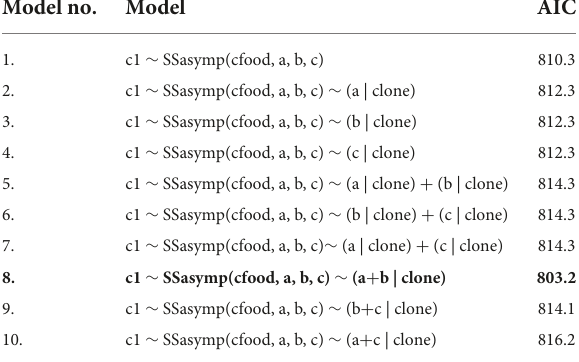
TABLE 5 First clutch abundance reaction norm models, fitted using random regression mixed models (RRMM). Model no.